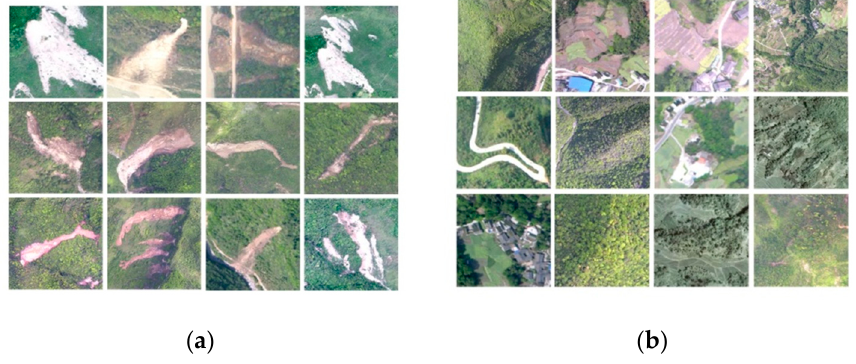
Figure 12. Example sample library. ( a ) Positive samples ( b ) Negative samples.